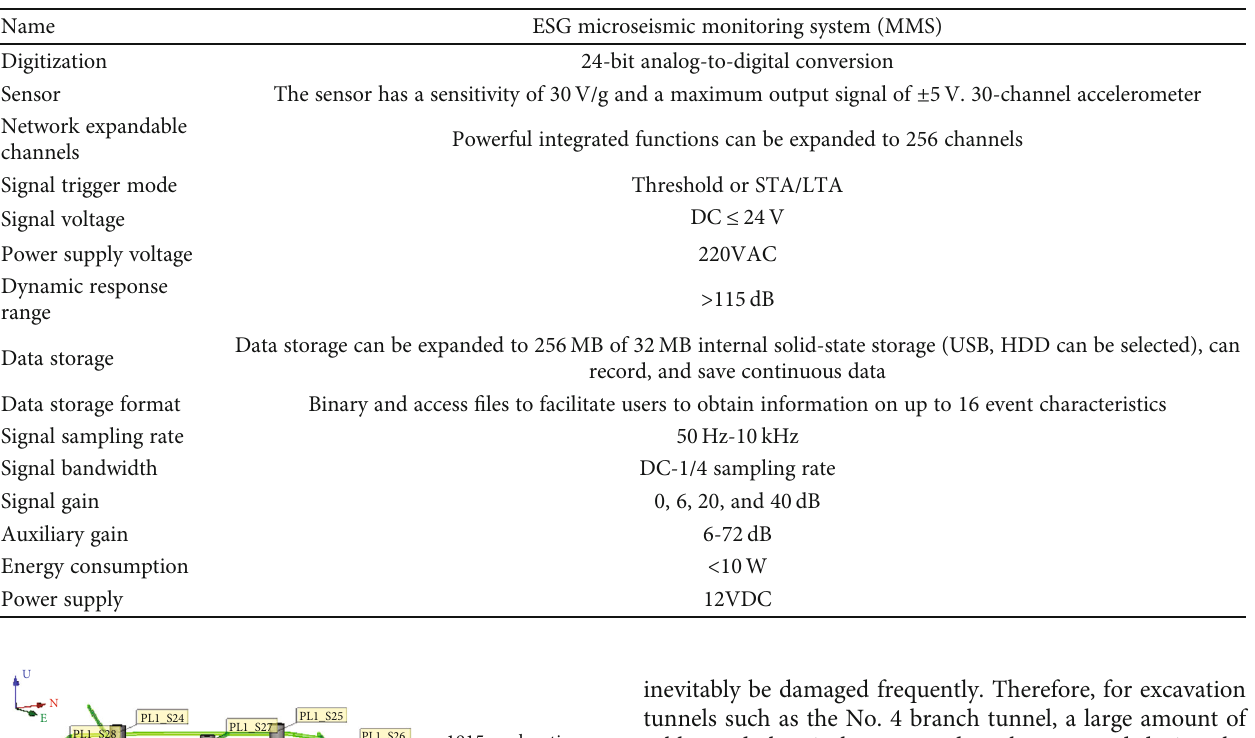
Table 2: Technical parameters of each component.